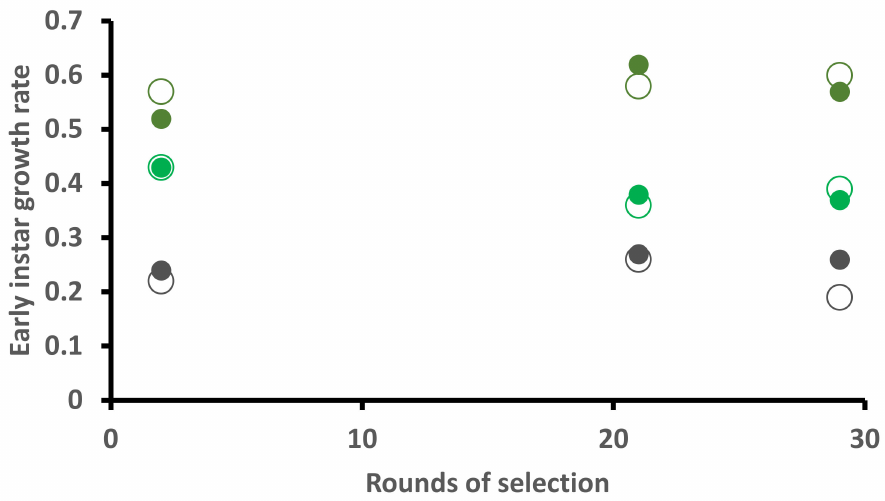
Figure 2. Growth rate ( ln weight gain/time in days) of early instars of Helicoverpa armigera Toowoomba strain (large open circles) and Brassica-selected strain (solid smaller circles) when reared on artificial diet (brown), cabbage (dark green) or kale (light green) assessed at the indicated rounds of selection (Supplementary Table